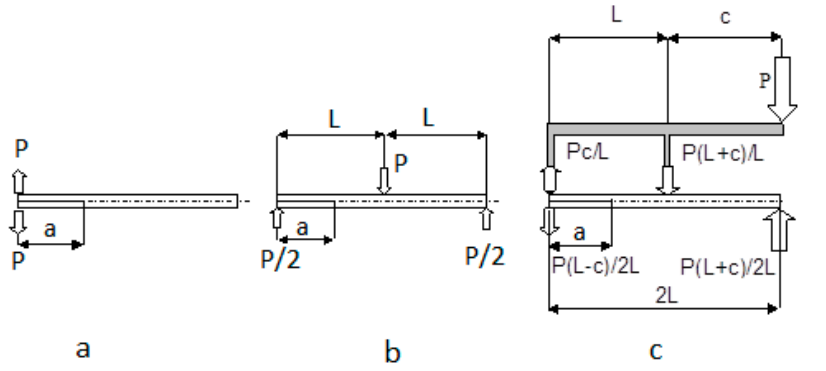
Figure 7. Loading schemes applied in the case of: ( a ) Mode I (ASTM D5528); ( b ) Mode II (ASTM D7905); ( c ) Mixed-Mode I/II (ASTM D6671) tests.